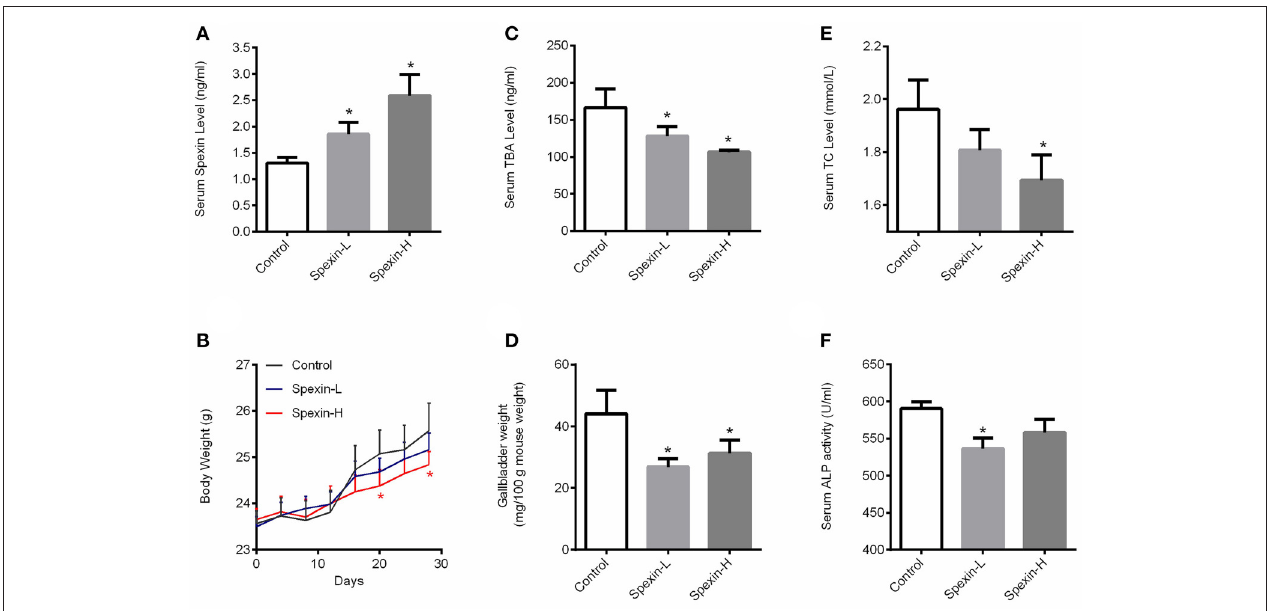
FIGURE 3 | Long-term injection of spexin for 28 days altered total bile acid pool in mice. The mice were i.p. injected with spexin (Spexin-L: 12.5 µ g/kg and Spexin-H: 25 µ g/kg) or saline daily for 28 consecutive days. Body weight was monitored every 4 days. At the end of the experiment, blood, liver, and gallbladder were harvested for further analysis. (A) Circulating spexin level in mice with/without spexin injection. (B) Spexin (25 µ g/kg) inhibited mouse body weight gain. (C) Spexin reduced serum TBA concentration in mice. (D) Spexin decreased gallbladder size. (E) Spexin suppressed serum TC level. (F) Spexin inhibited serum ALP acitivity. Results are shown as Mean ± SEM ( n = 10/group). * p < 0.05 vs. control resulting from Student’s t